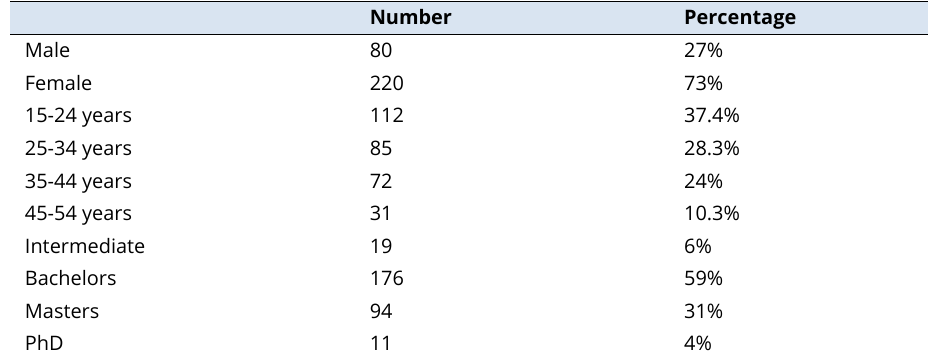
Demographic Results.